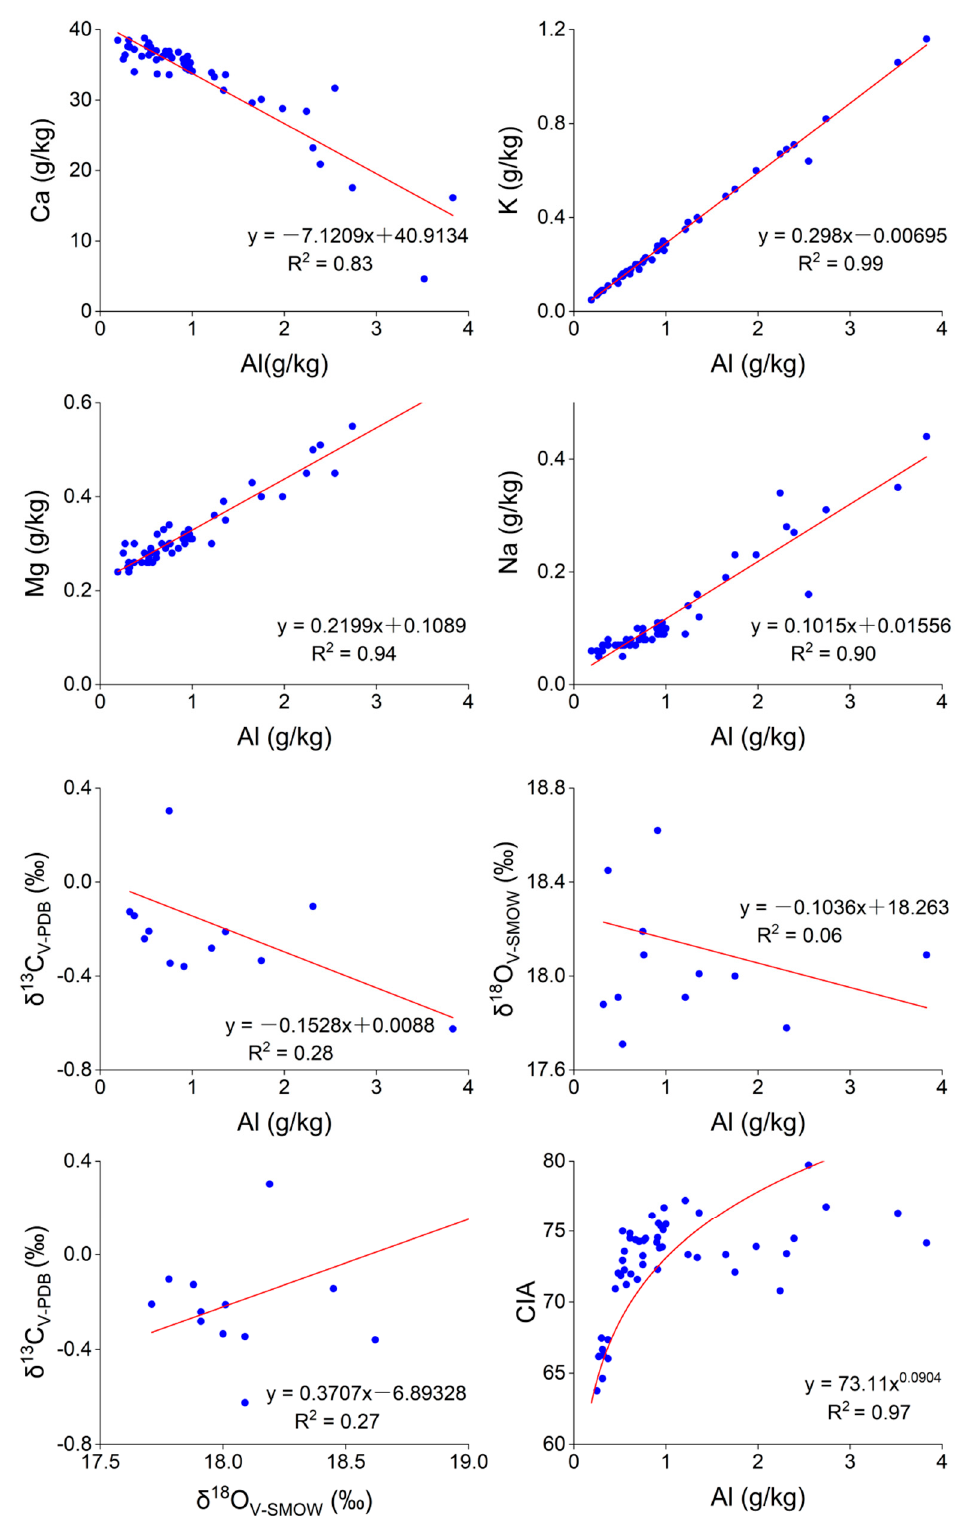
Figure 6. Correlation map of the main elements and carbon-oxygen isotopes of the calcareous tufa profile in the Sparkling Lake. It shows the correlation between elements (K, Na, Al, Mg, Ca, and CIA) and the plots of δ 13 C V-PDB and δ 18 O V-SMOW .